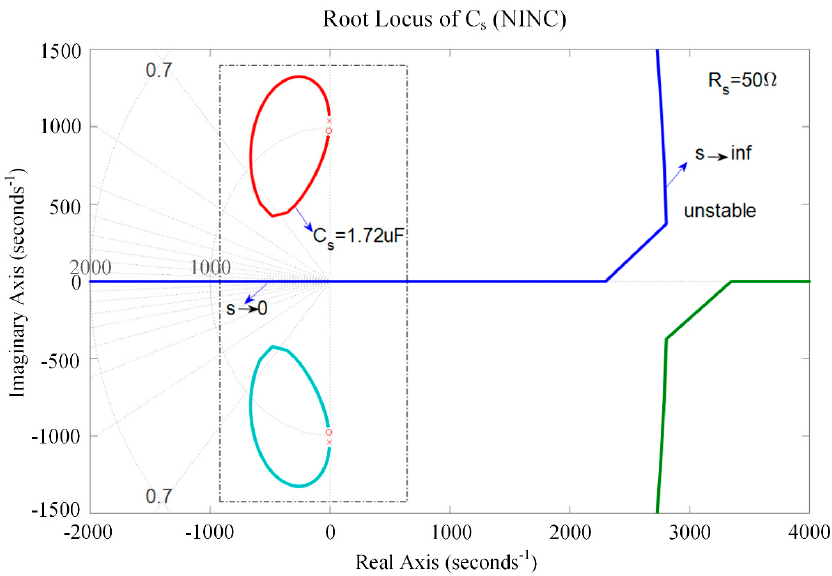
Figure 10. Root locus of the piezoelectric stack transducer with respect to C s for the negative capacitance in parallel with R s .